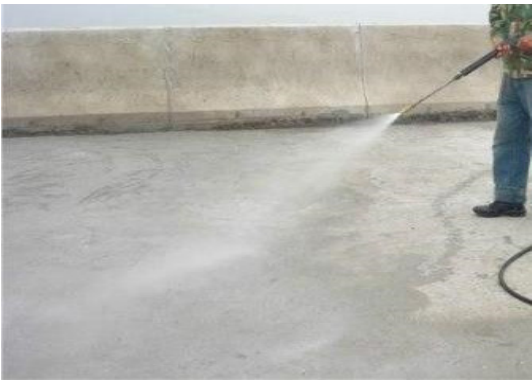
Figure 4. Spraying conservation agent curing method.